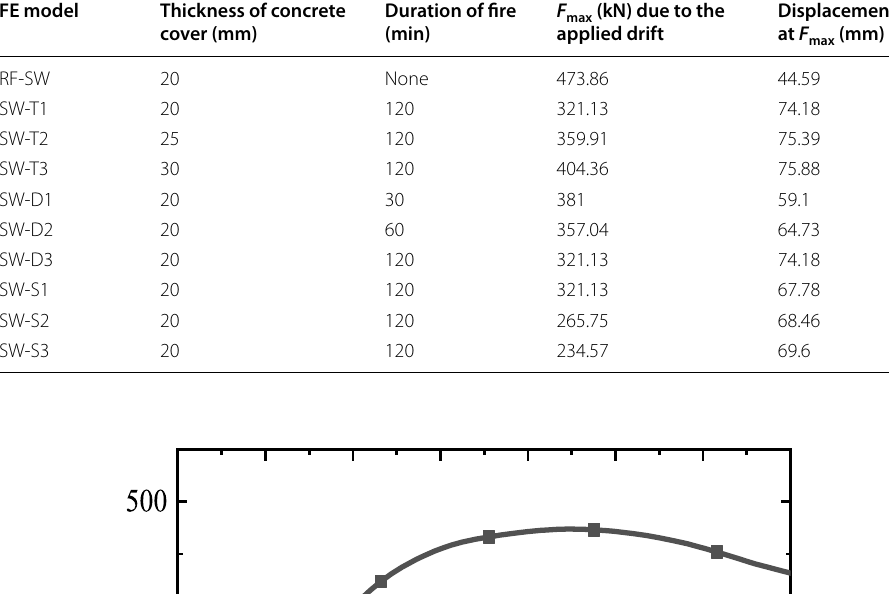
Table 3 Summary of fire exposed RC shear wall responses due to different cover FE model